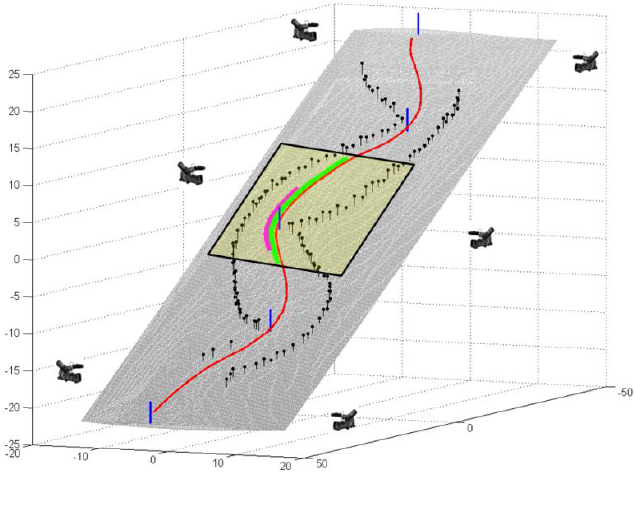
Figure 1. Illustration of the experimental setup at turn eight. The gates are plotted in blue, the calibration points for the video-based 3D kinematic system in black, skier CoM trajectory in red, the analyzed area in yellow, the analyzed turn cycle in green and the analyzed turning phase in